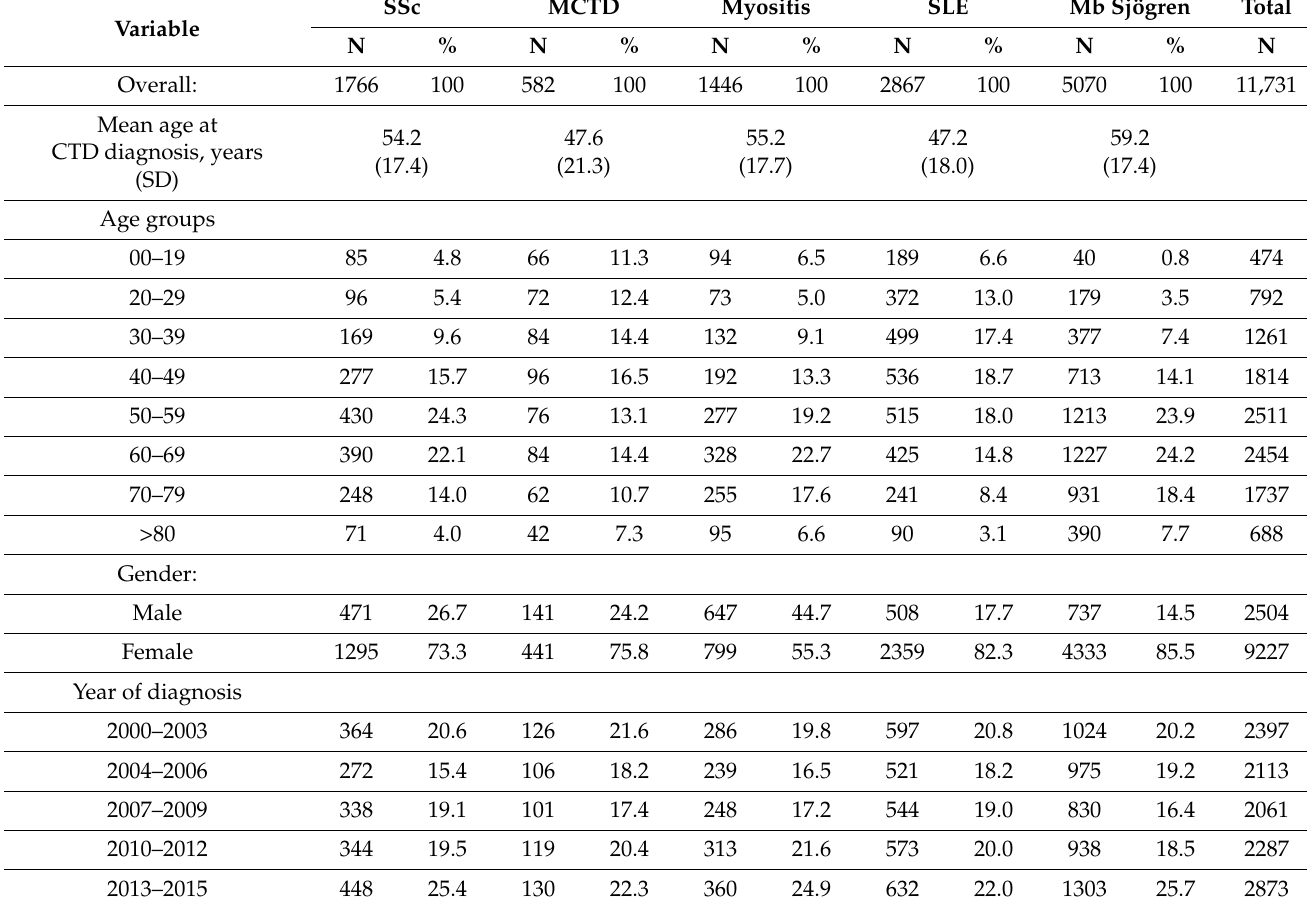
Table 1. CTD: Age and gender distribution within each CTD subgroup and frequencies of each CTD diagnosis over time.